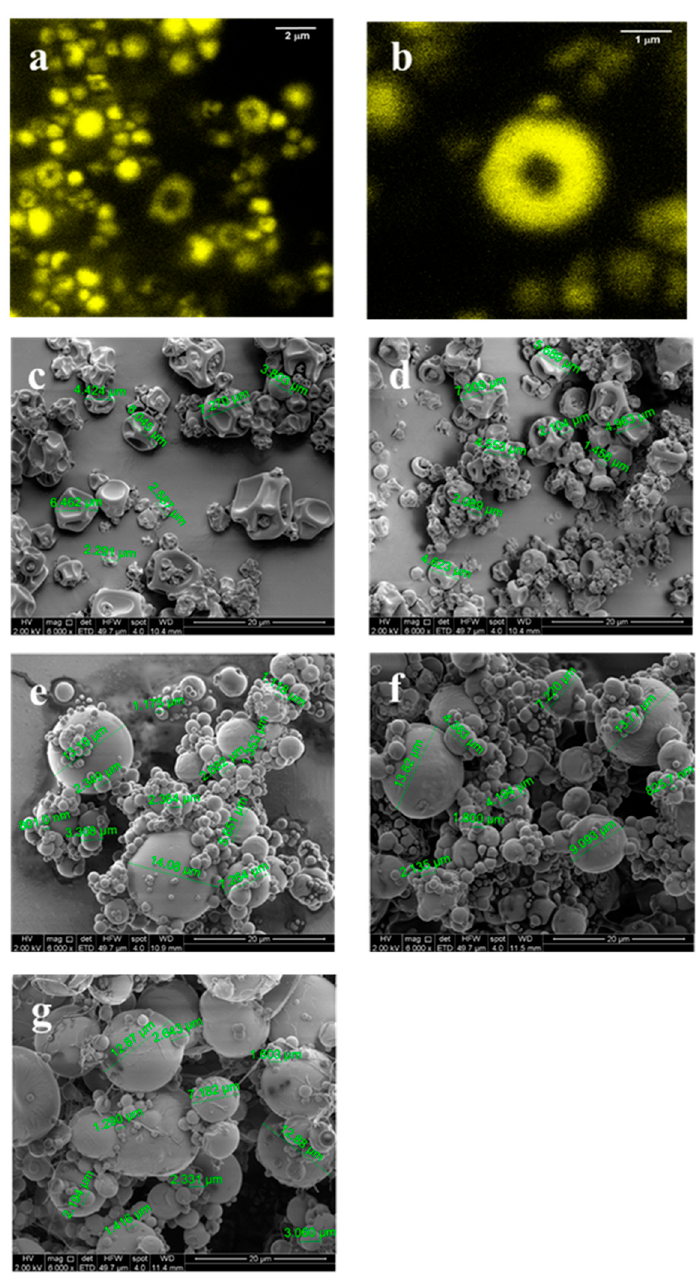
Figure 3. CLSM micrographs for PWO-C / SA ( a , b ). SEM micrographs of PWO-C microparticles ( c ), PWO-C / SA microparticles ( d ), PWO-C(AA) / SA microparticles ( e ), PWO-C / SA(AA) microparticles ( f ) and PWO-C (AA) / SA(AA) microparticles ( g ).